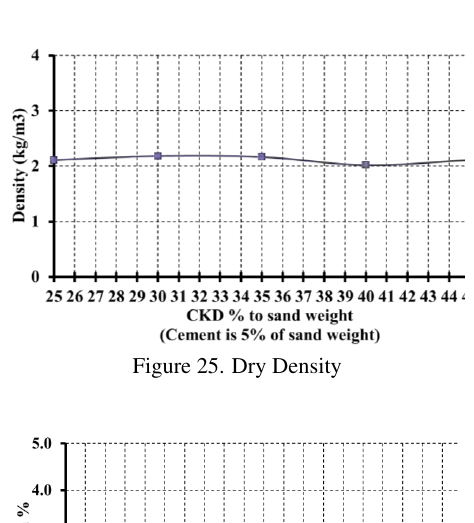
Figure 24. Dry flexure